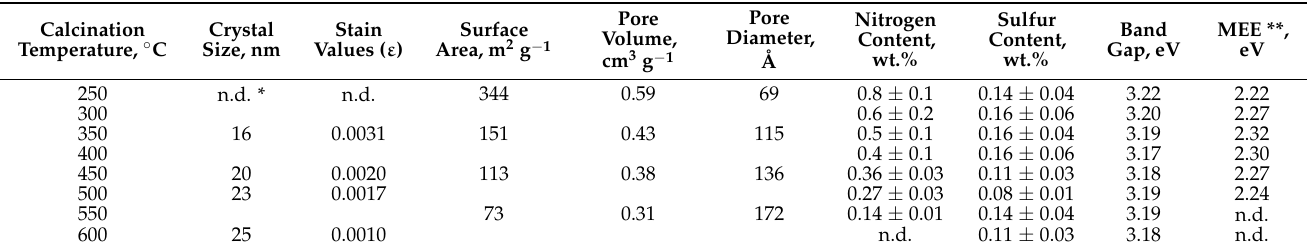
Table 1. Characteristics of the samples calcined at different